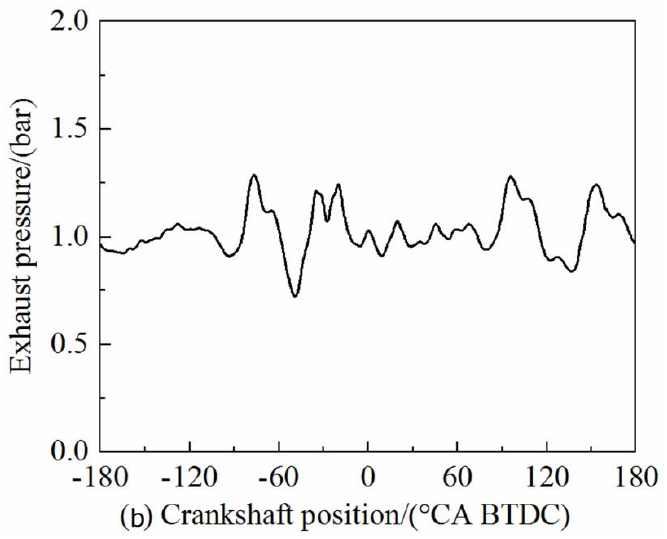
Figure 7. Boundary conditions for pressure inlet and outlet: ( a ) crankcase pressure; ( b ) exhaust pressure.